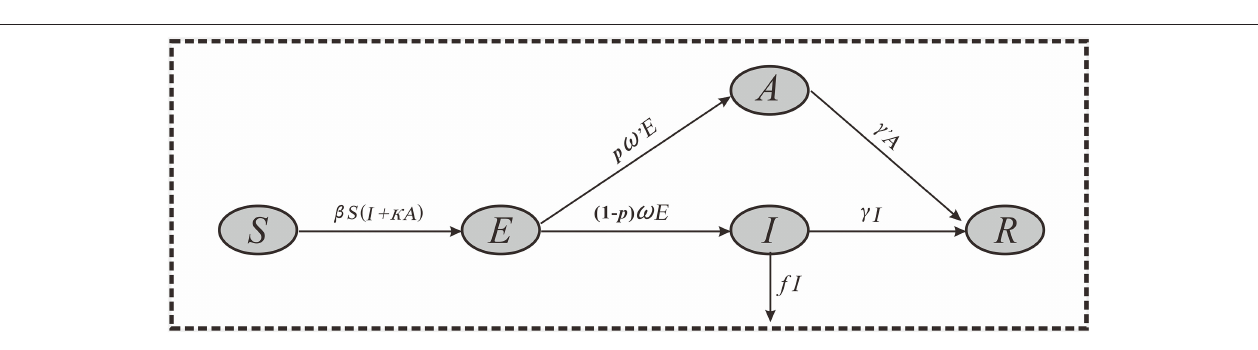
4) Assuming that the infectious period of the recessive infected person A is 1/ γ ′ , then at time t , the number of people who change from A to R is γ ′ A .